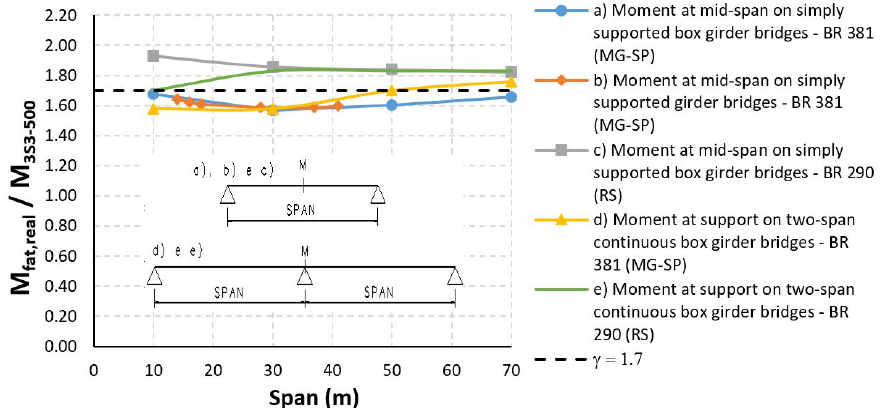
Figure 22. Bias factors for bending moment related to the proposed